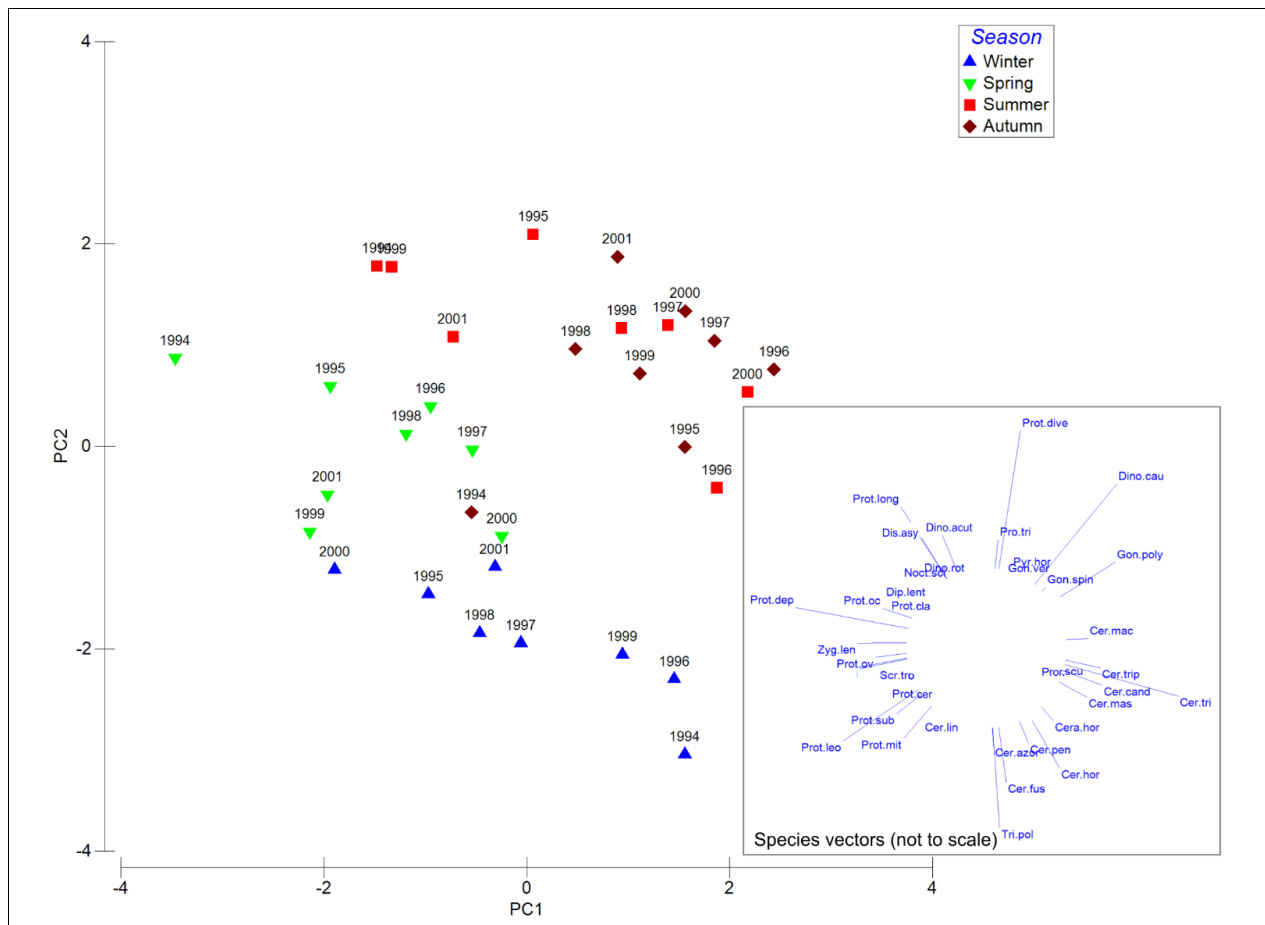
FIGURE 6 | PCA analysis of seasonally averaged standardized abundances of the 50 most common dinoflagellates species. PC1 and PC2 explain 14.6% and 12.2% variability respectively. Species codes are listed in the Supplementary Appendix 1